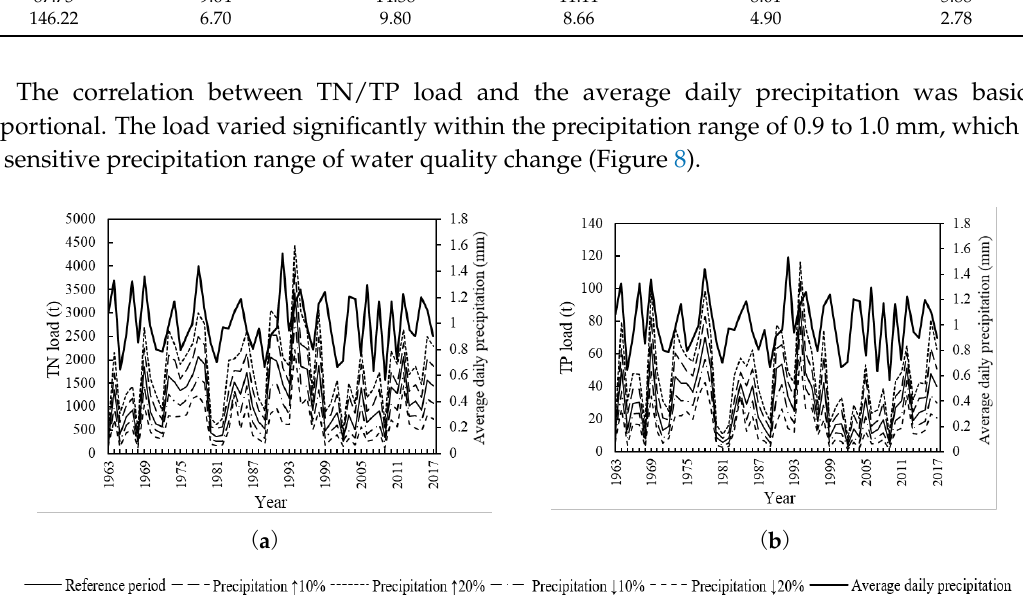
Figure 8. TN load ( a ), TP load ( b ) and average daily precipitation variations under the Precipitation Change scenario.